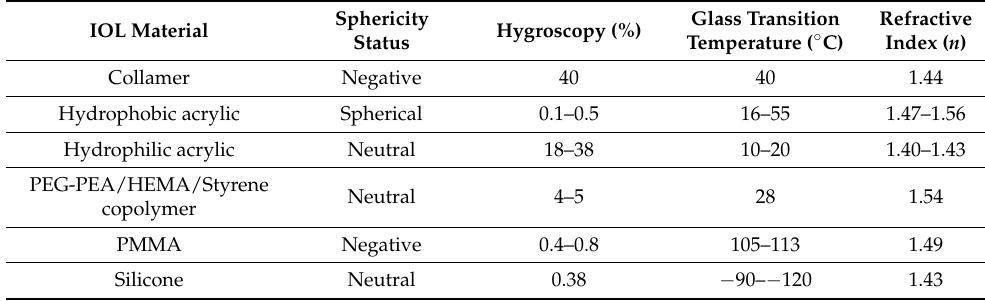
Table 3. IOL materials and their